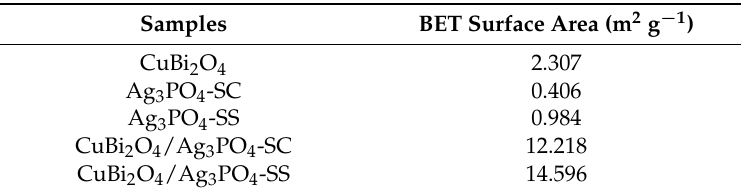
Figure 4. ( a ) Degradation efficiency of diclofenac sodium (DS) over different photocatalysts; ( b ) effect of H 2 O 2 concentration on the removal efficiency of DS over CuBi 2 O 4 /Ag 3 PO 4 -SC and CuBi 2 O 4 /Ag 3 PO 4 -SS; ( c ) removal efficiency of TOC under different photocatalyst systems. Table 1. Specific surface area of the as-prepared